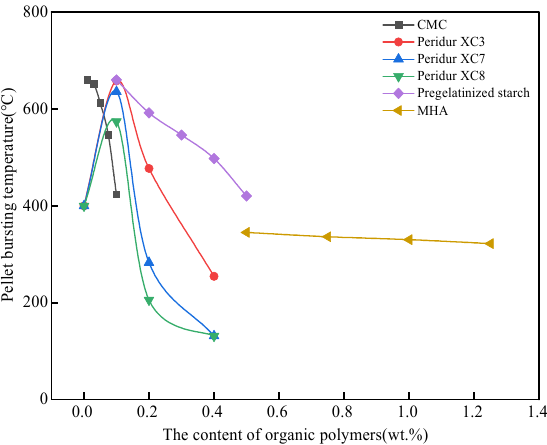
Figure 8. The effect of organic polymers on the pellet bursting temperature [96–99].